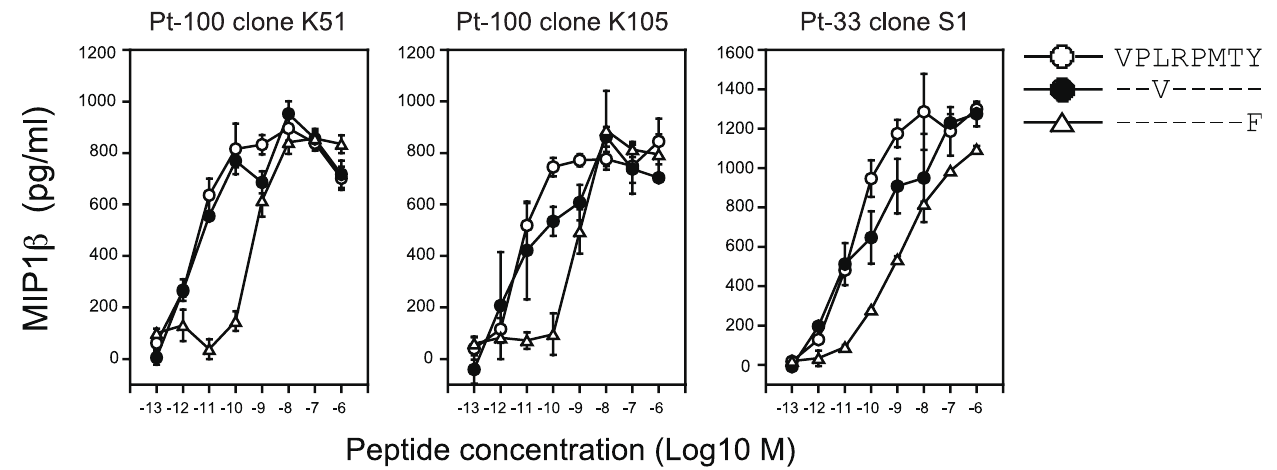
Figure 3. VY8-specific CD8 + T cell sensitivity towards peptide variants. The sensitivity of T cell clones towards the VY8, VY8-3V and VY8-8F peptides was quantified by measuring the amount of MIP-1 b secreted in response to antigen stimulation. Data are representative of duplicate assays and standard deviation from the mean of two replicates is shown.